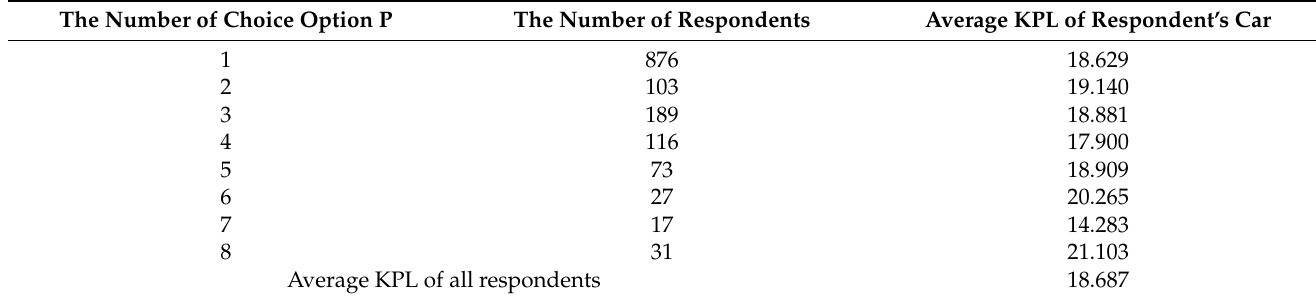
Table 5. The survey results for questions about time